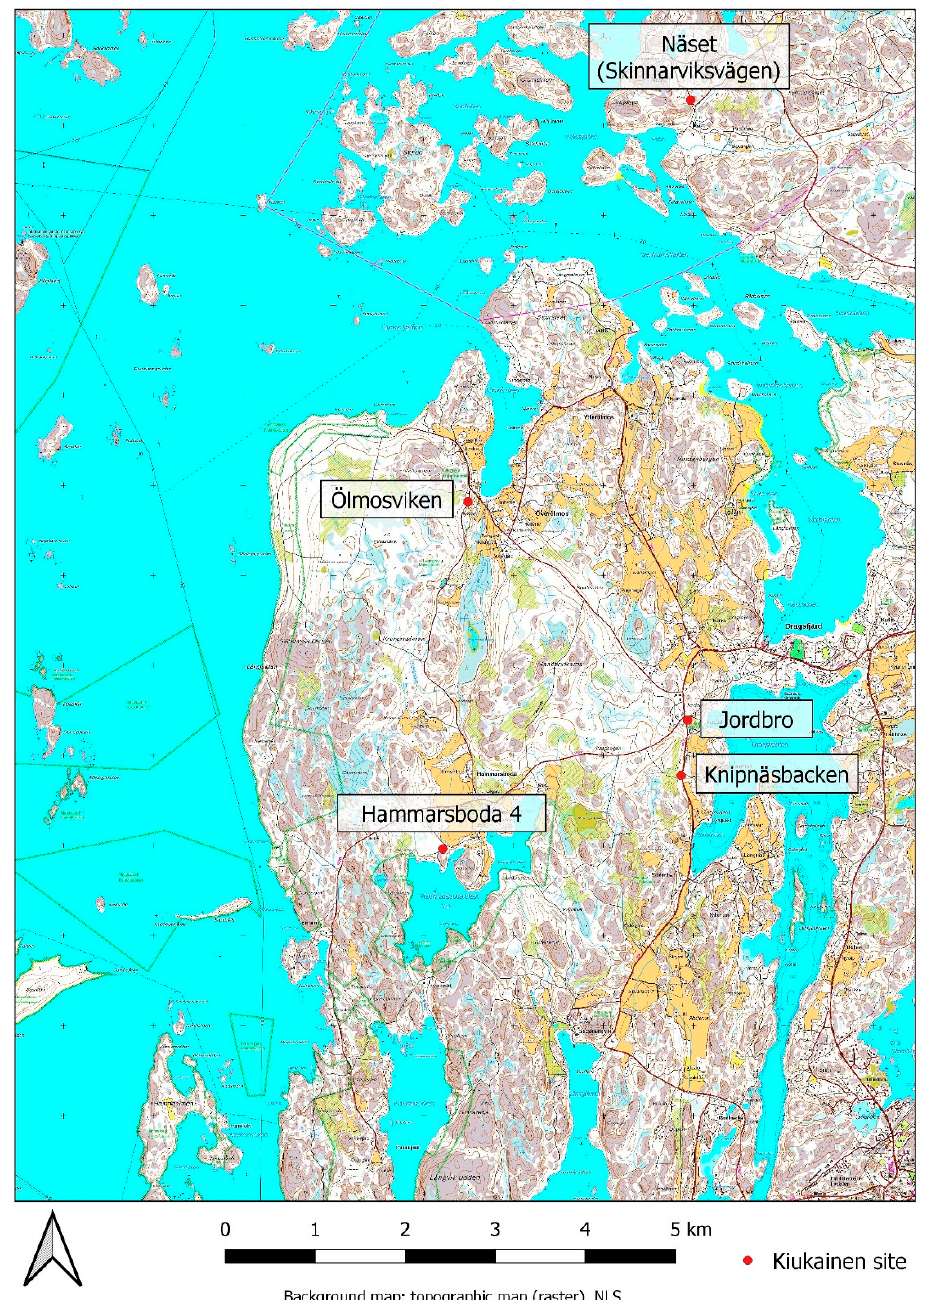
Figure 5. The locations of Kiukainen sites in the Kemiönsaari area. Grey areas in the background of the map are rocky areas, while the yellow areas are cultivated fields, and the light green or empty white areas in between are forests.